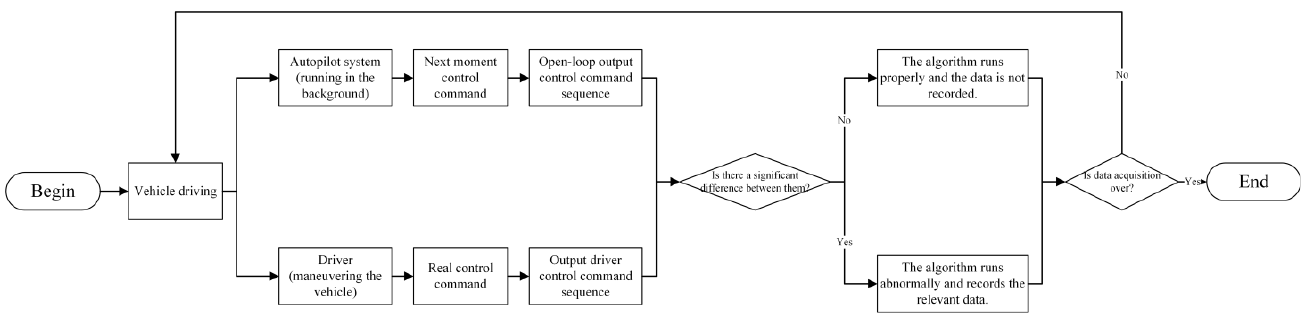
Figure 4. Process of identifying scenarios that are difficult for the autopilot system to handle.